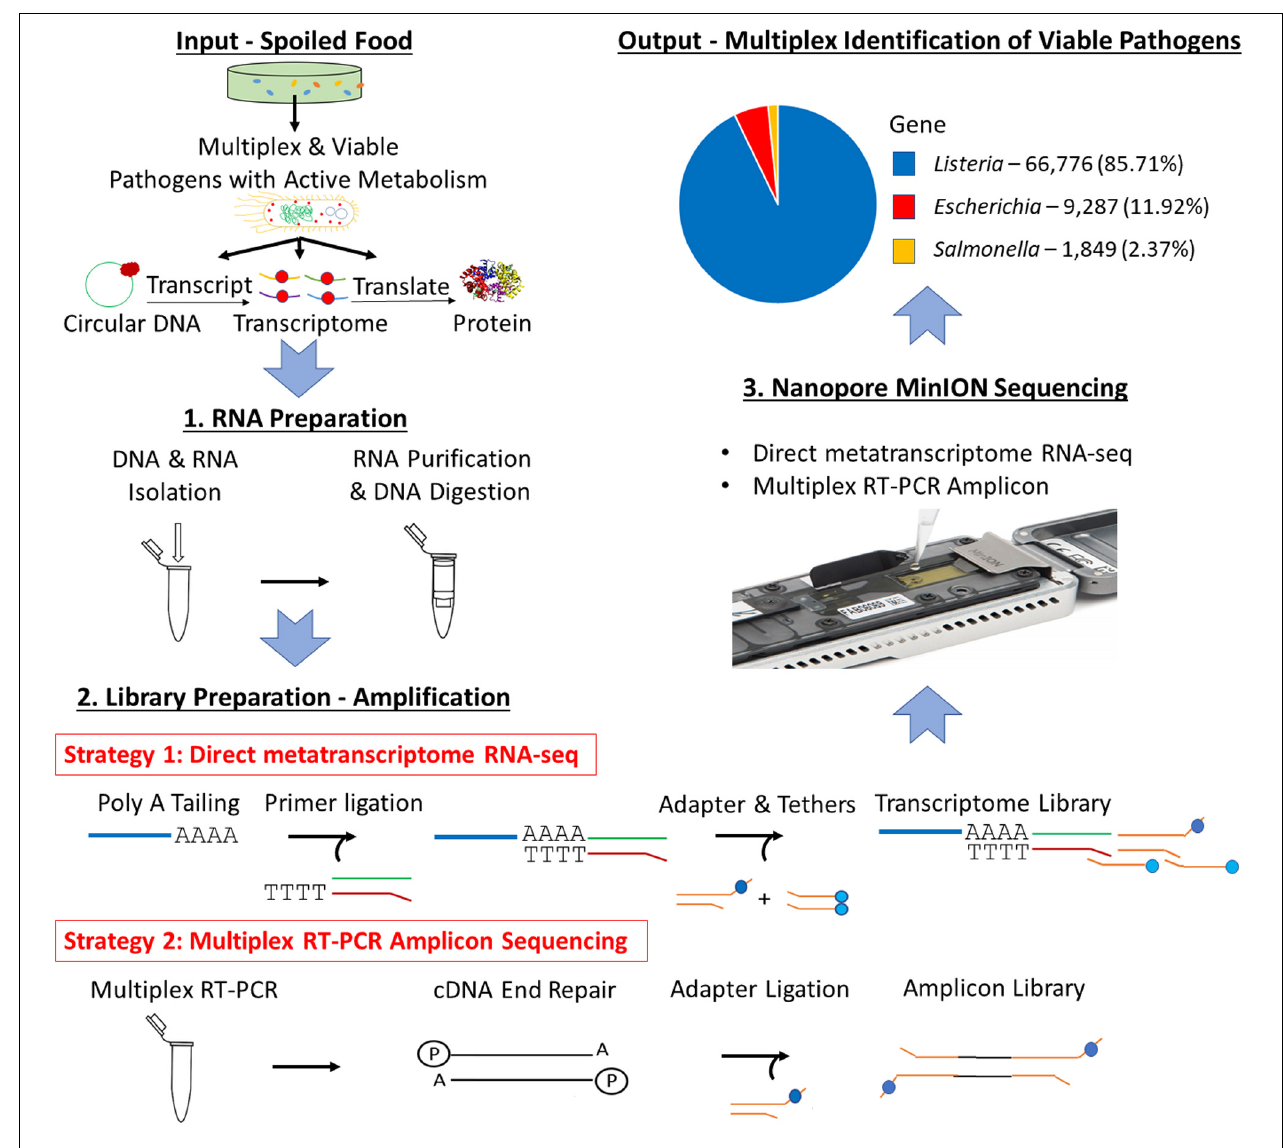
FIGURE 1 | Scheme of multiplex identification of viable pathogens on Nanopore